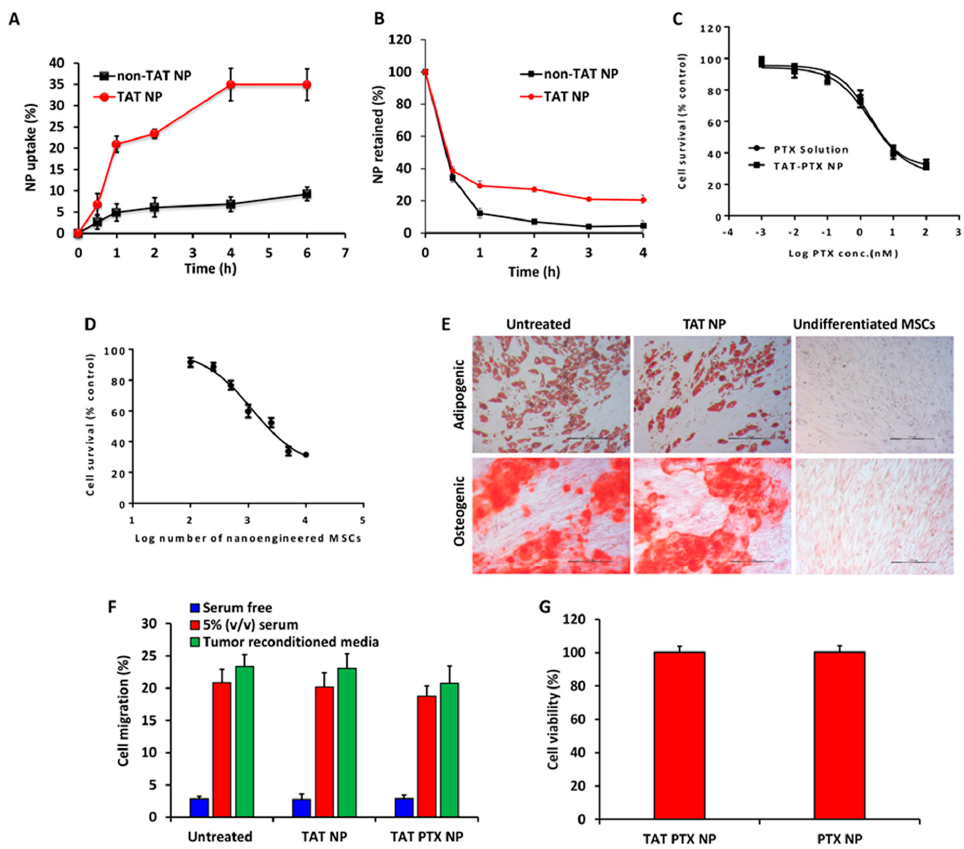
Figure 2. In vitro endocytosis ( A ) and exocytosis ( B ) of TAT-modified or non-TAT nanoparticles in MSCs. Cells were incubated with 100 µg/mL rhodamine-labeled PLGA nanoparticles. Data shown is mean ± SD, n = 4. ( C , D ) Cytotoxicity profiles of PTX solution, TAT PTX NP, and nano-engineered MSCs in A549 cells. Cells were treated with PTX solution or TAT PTX NP ( C ) or nano-engineered MSCs ( D ). MTS assay was performed after 72 h of treatment. Data shown is mean ± SD, n = 6. ( E ) Differentiation (adipogenic and osteogenic) potential of nano-engineered MSCs (MSCs engineered with TAT NP; TAT NP). Untreated MSCs and nano-engineered MSCs were grown in adipogenic and osteogenic differentiation media for 3 weeks. The cells were fixed and stained with oil red O or alizarin red to detect lipid vacuoles or calcium deposits, respectively. MSCs cultured in regular growth media were used as negative control. Scale bar: 200 µm. ( F ) The migratory potential of MSCs from a serum free media towards serum free, tumor reconditioned or 5% ( v/v ) serum containing media in a Transwell® plate. Data shown is mean ± SD, n = 6. ( G ) Cell viability of nano-engineered MSCs. Data shown is mean ± SD, n = 5.